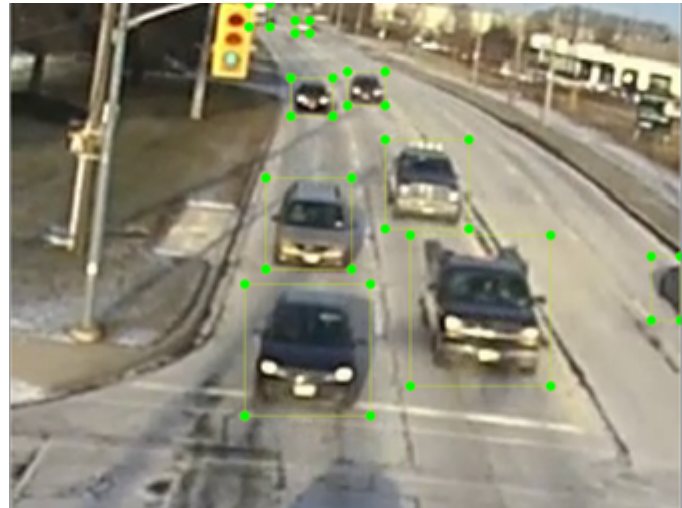
Figure 6. Labeled image for transfer